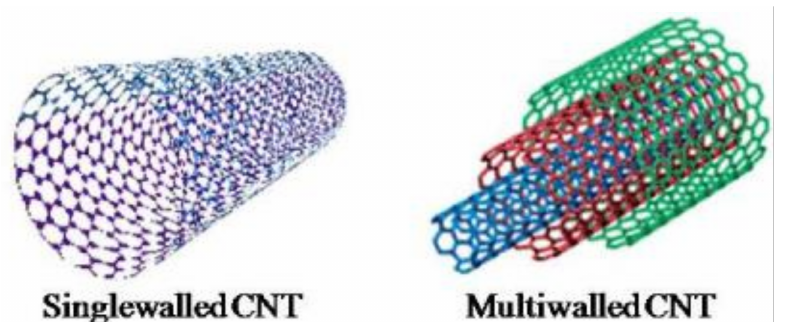
Figure 3. Single-walled and multiple-walled carbon nanotubes (CNT)